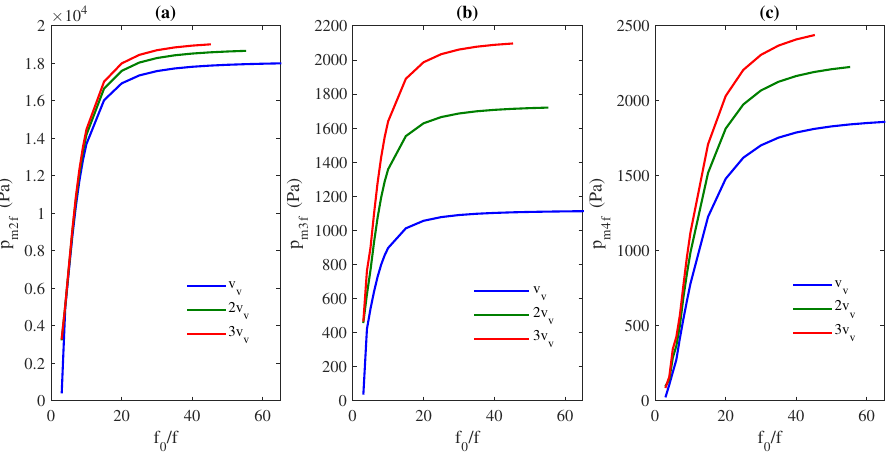
Figure 3. Maximum amplitude of 2 f ( a ), 3 f ( b ), 4 f ( c ) in the cavity of length L = λ /4 vs. f 0 / f , for three different void fractions v v (blue line), 2 v v (green line), and 3 v v (red